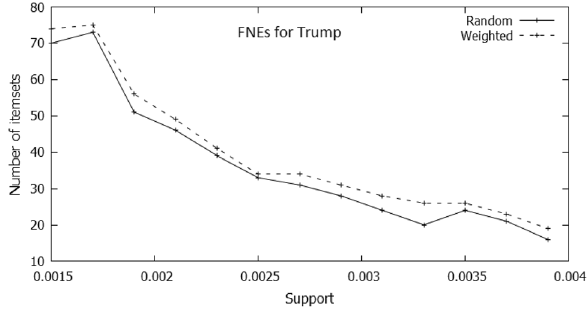
Fig. 5 Average number of itemsets for Trump